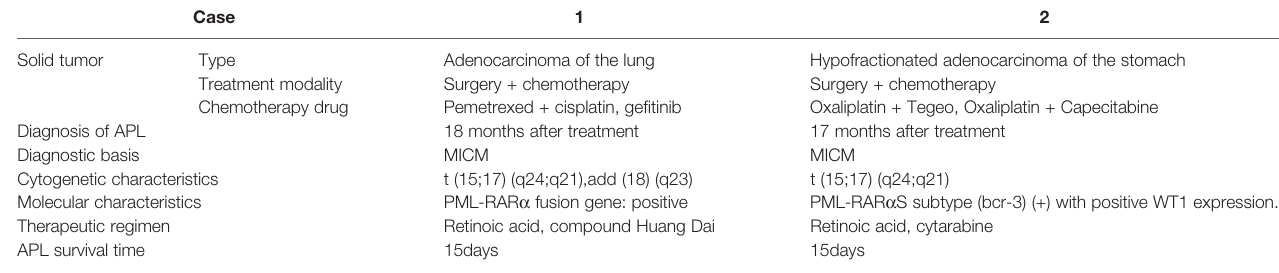
TABLE 1 | Summary of MPC in 2 cases with combined